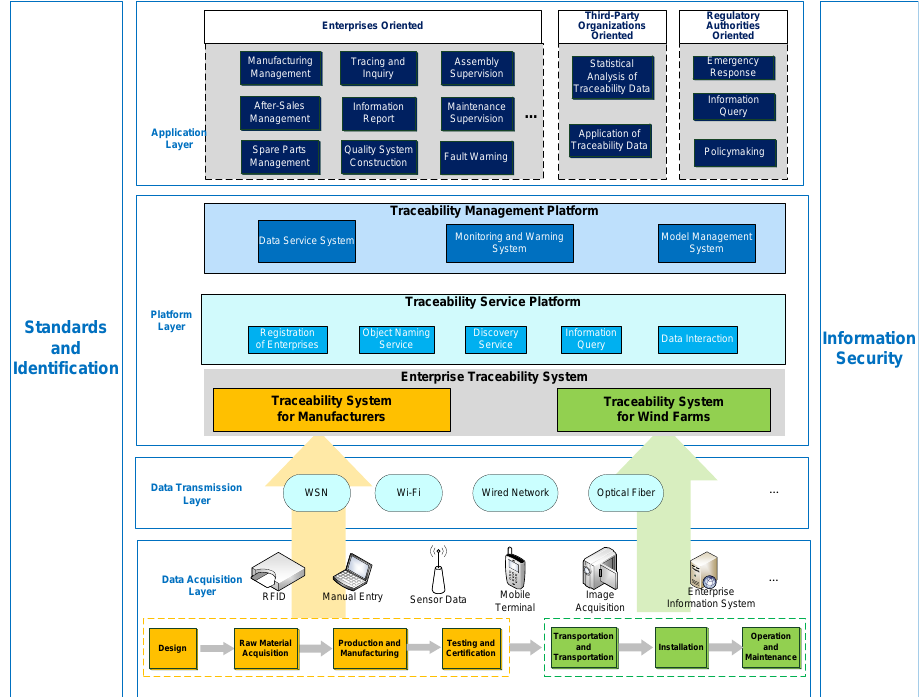
Figure 1. The architecture of the proposed IoT-based traceability platform for wind turbines. Table 2. The detailed information on each stage of wind